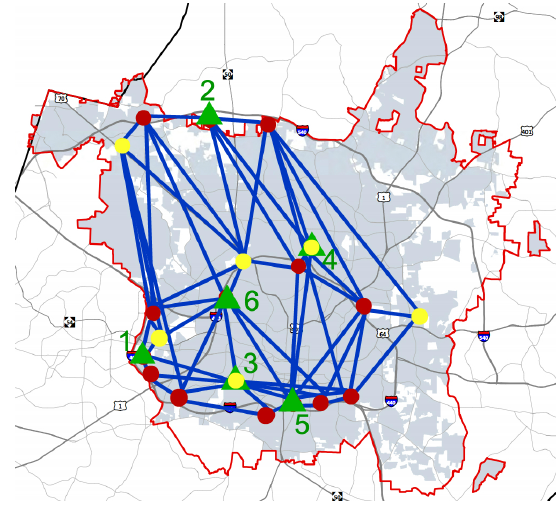
Figure 7. Locations of fast charging station (FCS) comparison